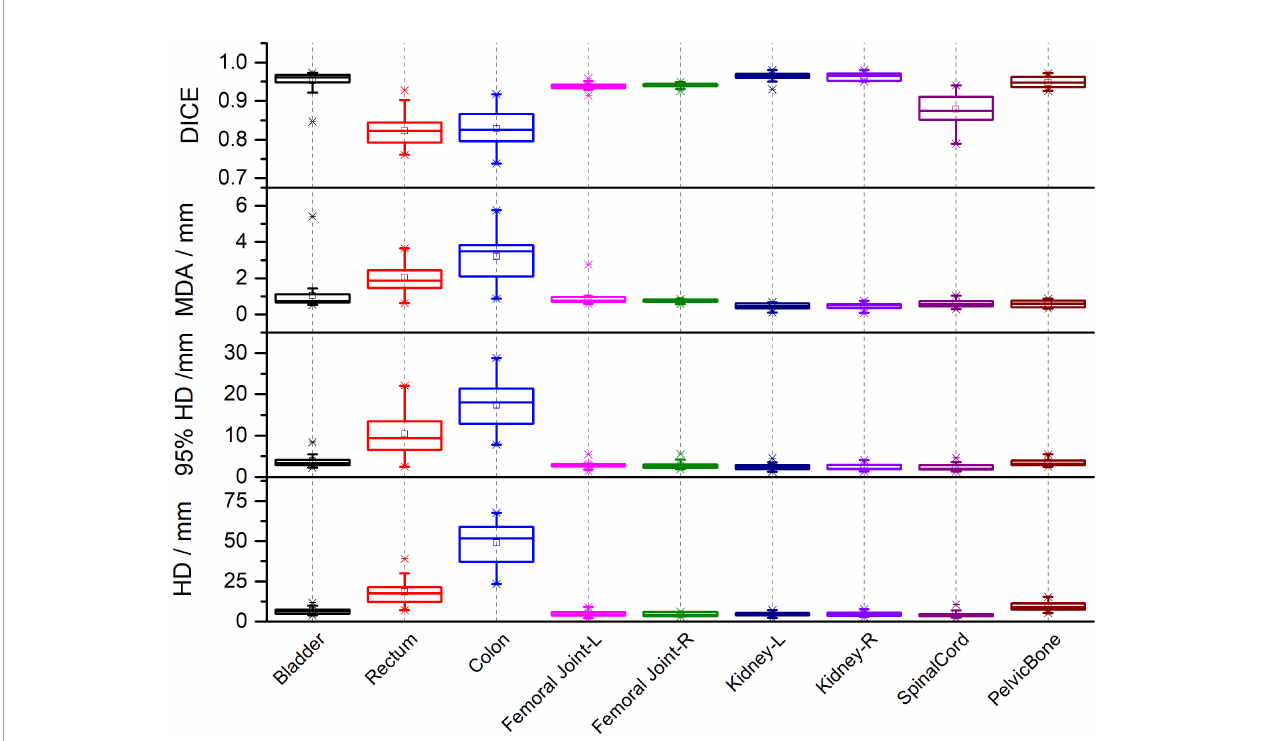
FIGURE 2 | The Dice similarity coef fi cients (DSC), Mean Distance to Agreement (MDA), Hausdorff Distance (HD) and 95th-percentile of the HD between automated segmentation and manual segmentation for each organ at risk in the testing